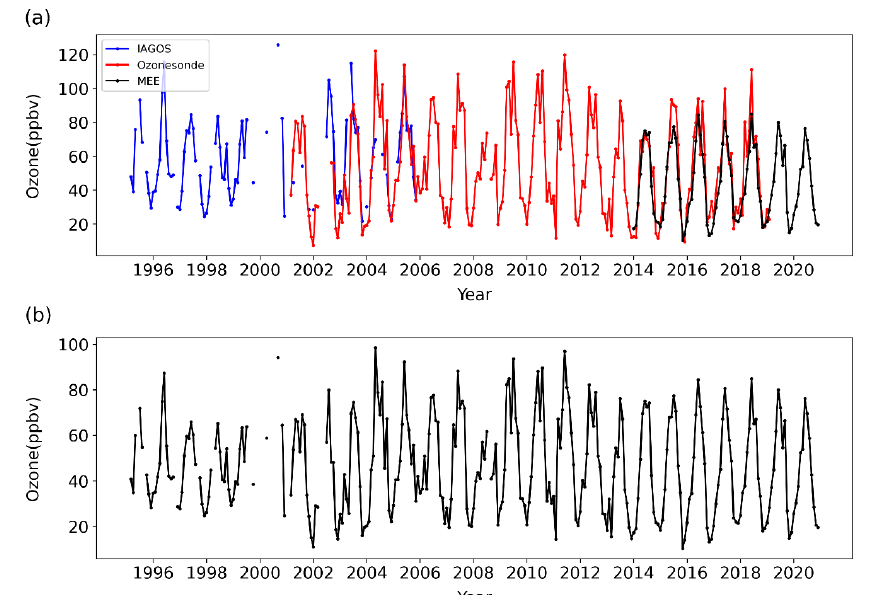
Figure 4. The relationship of ozone mixing ratio at 14:00 BJT measured by MEE and ozone mixing ratio at other time (06:00 BJT, 09:00 BJT, 10:00 BJT, 11:00 BJT, 12:00 BJT, 13:00 BJT, 15:00 BJT, 16:00